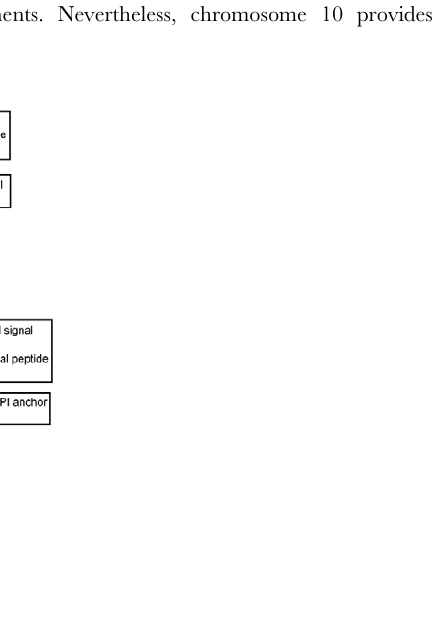
Figure 1. Frequency distribution of pairwise sequence divergence between 6929 single-copy gene orthologs in T.b.brucei and T.b. gambiense . Divergence values to the right of the dashed line are statistically significant; the identities of selected divergent gene pairs are noted. An asterisk * denotes genes belonging to a T. b. brucei subspecies-specific tandem gene array (see Figure 2 and Supplementary Figure S2).